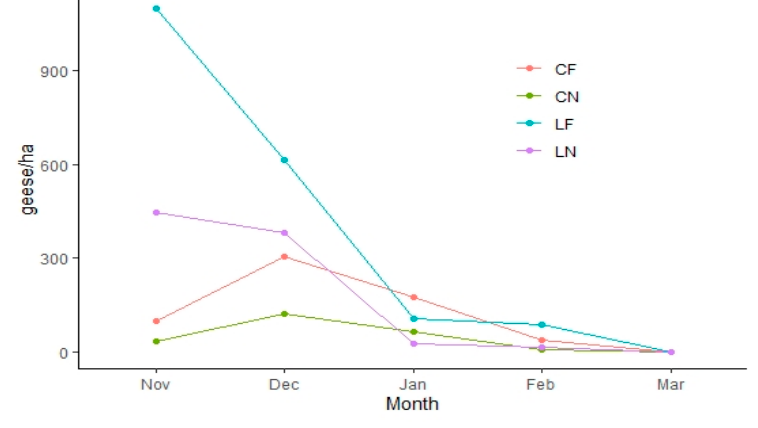
Figure 3. Mean abundances of Geese per Treatment.